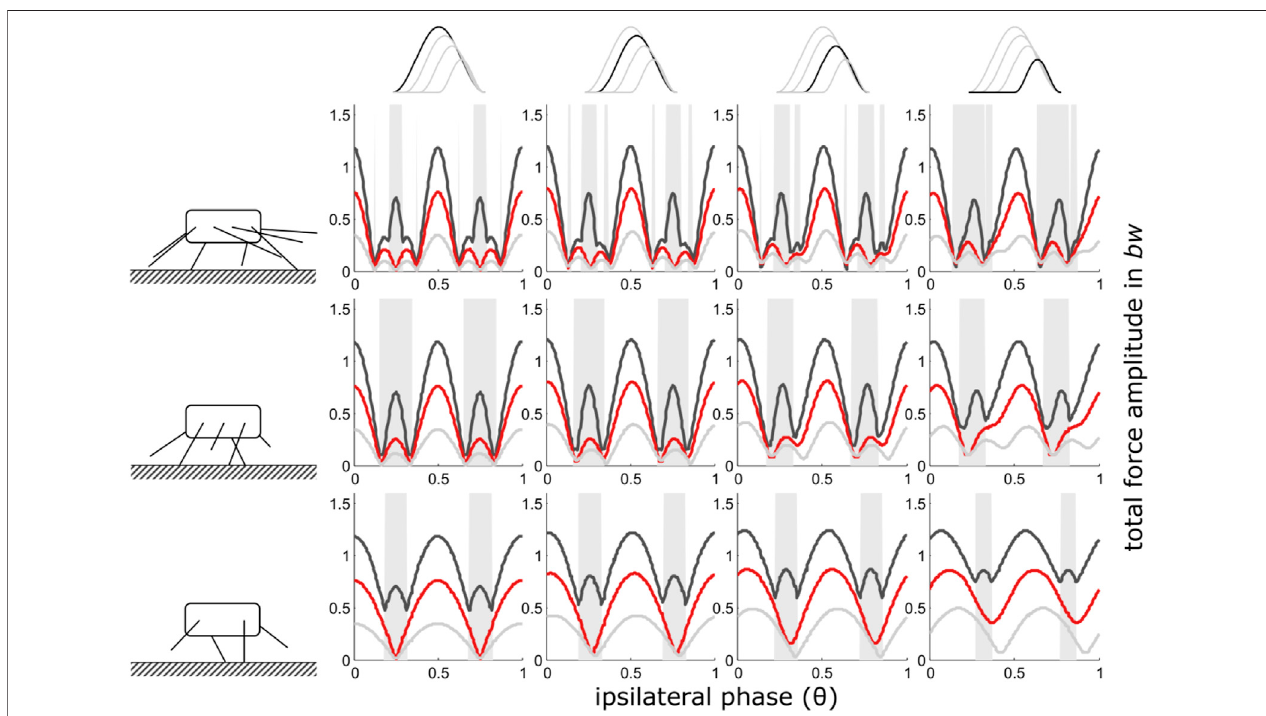
FIGURE 4 | Take-off as reference point (iv): Dependency of total vertical leg force amplitudes on the phase shift of ipsilateral adjacent legs and duty factor with gradually decreasing contributions of increasing numbers of leg pairs. GRF decreased while their shape (ratio of width to height) remained constant i.e. also contact durations decreased with the reduction of the impulses beneath leg pairs. Duty factors shown: 0.3 (dark grey), 0.5 (red) and 0.8 (light grey). The top row indicates the degree of reduction in the pair of legs with reduced GRF and the type of force alignment (take-off (iv)). Accordingly, in the third column from the right, the impulse beneathonelegpairisreducedby¼,inthe2 nd columnfromtherightby½andintherightmostcolumnby¾.Thepictogramstotheleftindicatethenumberofpropulsive pairs oflegsvalidfortherespectiverow ofsubplots,i.e., fourin theupper row,three inthemiddlerow and twointhebottom row. Withlowdutyfactorsand intermediate phase shifts, the peak frequency of the force oscillations assumed values higher than two times the stride frequency; these intervals are shaded in